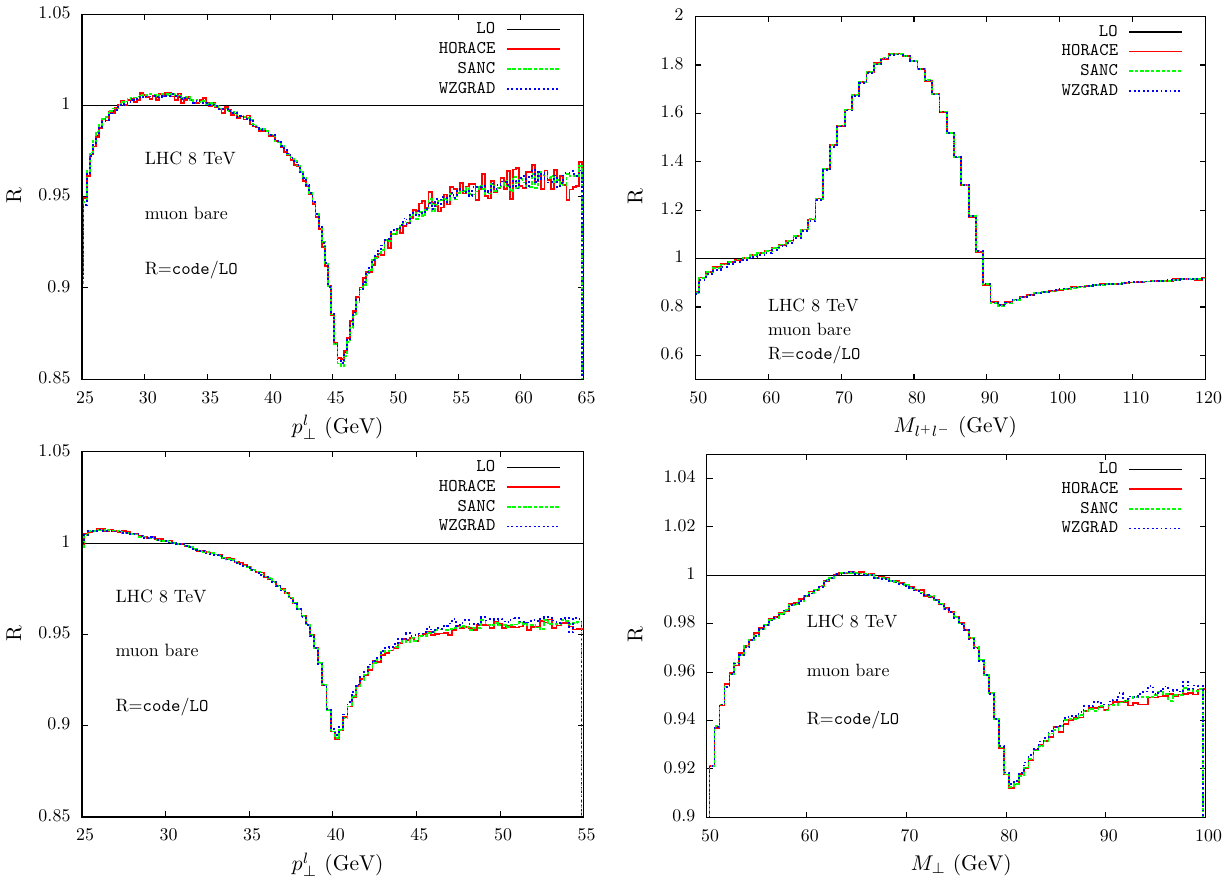
Fig. 24 Impact of NLO EW corrections in NC and CC DY processes with bare muon(s) at the 8 TeV LHC with ATLAS/CMS cuts, expressed inunitsofthecorrespondingLO,inthe benchmark setup,evaluatedwith different codes. In the upper panels , for the pp → μ + μ − + X process,